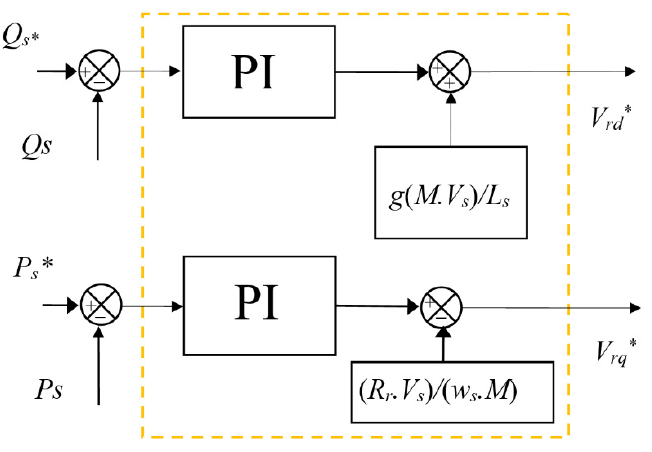
Figure 12. Structure of the traditional DVC method.